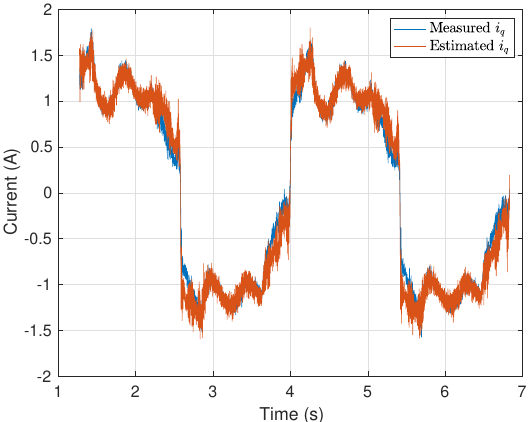
Figure 4. Model validation in the electrical